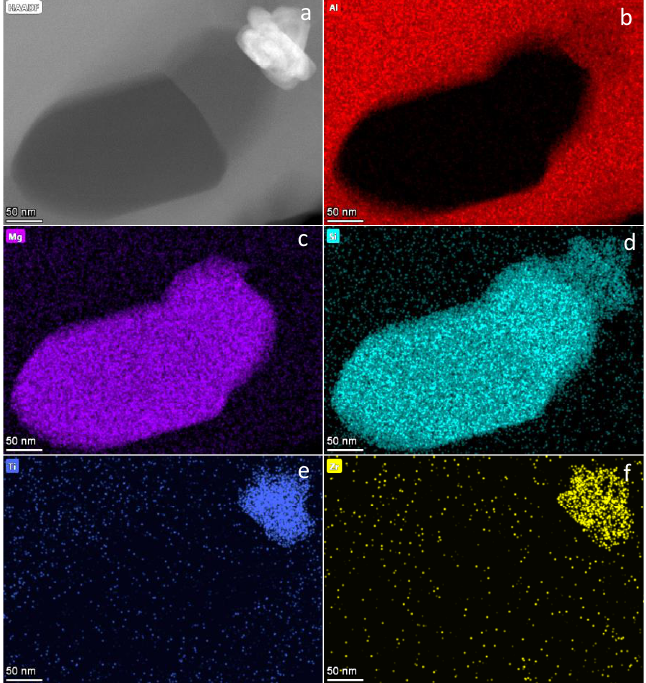
Figure 8. ( a ) High-angle annular dark-field scanning transmission electron microscope (HAADF- STEM) micrograph of precipitates within an α -Al grain in the as-built part; ( b – f ) corresponding energy-dispersive X-ray spectroscopy (EDX) maps for Al, Mg, Si, Ti, and Zr.